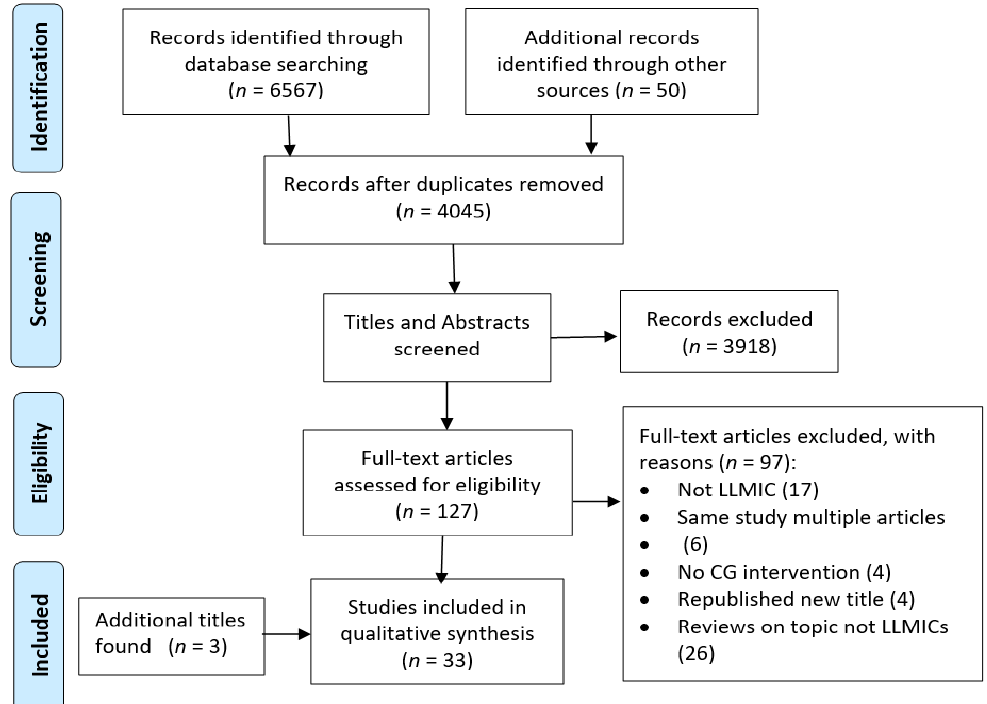
Figure 1. The preferred reporting items for systematic reviews and meta-analysis (PRISMA) flow chart detailing the selection of studies investigating strategies used for implementing and promoting adherence to antibiotic guidelines in low- and lower middle-income countries (LLMICs).